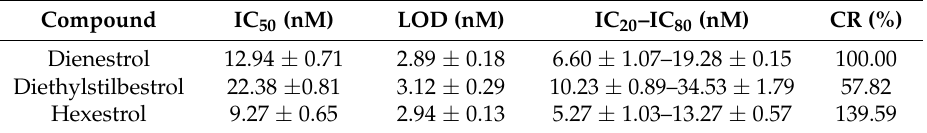
Table 1. Inhibitory concentrations (IC 50 ) values, limits of detection (LOD), and working ranges for three stilbenes in fluorescence polarization (FP) assay ( n =3). IC 50 , LOD, IC 20 , IC 80 values ± standard errors are presented.